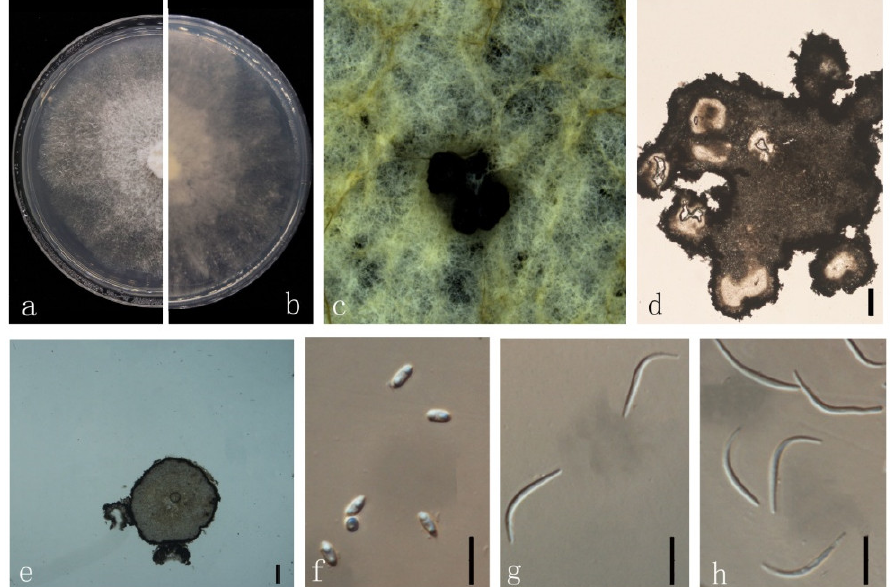
Figure 13. Diaporthe unshiuensis (ZHKUCC 22-0051) ( a ) upper view of colonies on PDA; ( b ) Reverse view of colonies on PDA; ( c ) Conidiomata sporulating on PDA; ( d , e ) Section of pycnidia; ( f ) Alpha conidia; ( g , h ) Beta conidia. Scale bars: ( d , e ) =100 µm; ( f – h ) =10 µm.